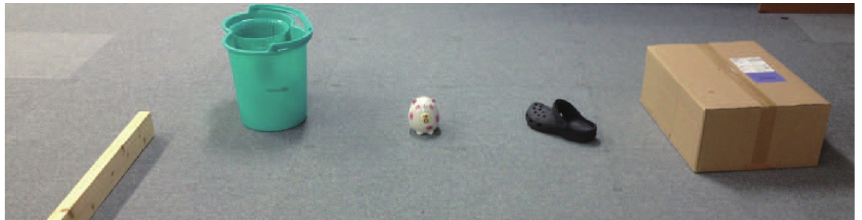
Figure 5. Experiment setups.